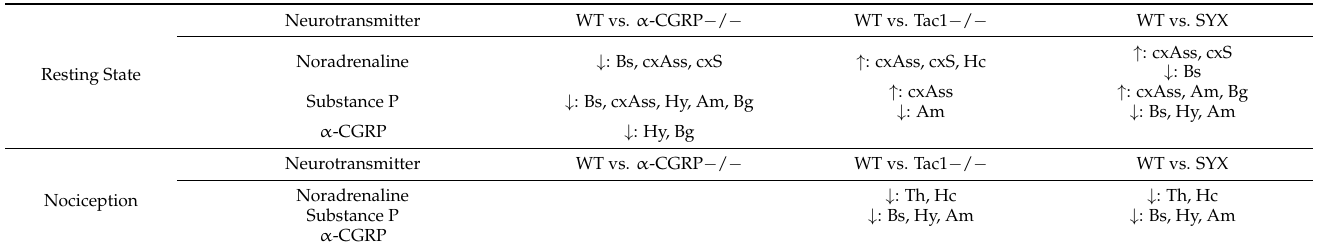
Table 1. Gene expression network correlation analysis data corresponding to Figure 5 (baseline differences in resting-state and nociceptive functional